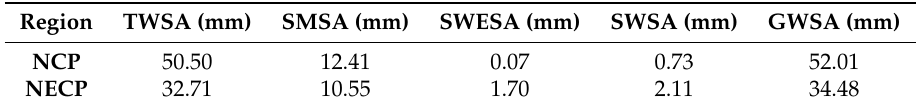
Table 4. The monthly errors for GWSA,TWSA,SMSA and SWSA derived from GRACE, GLDAS and in situ observation.